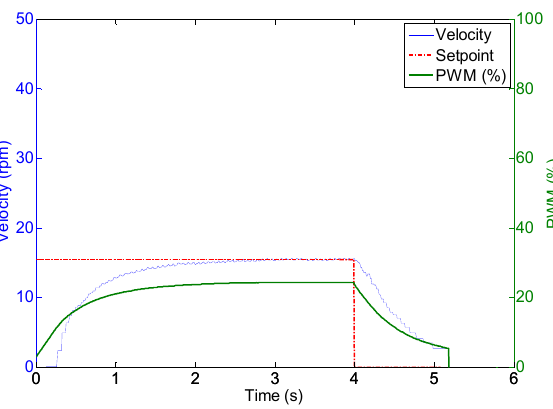
Figure 24. Wheel 3. Evolution of wheel velocity and applied motor PWM for a target velocity of 15 rpm.